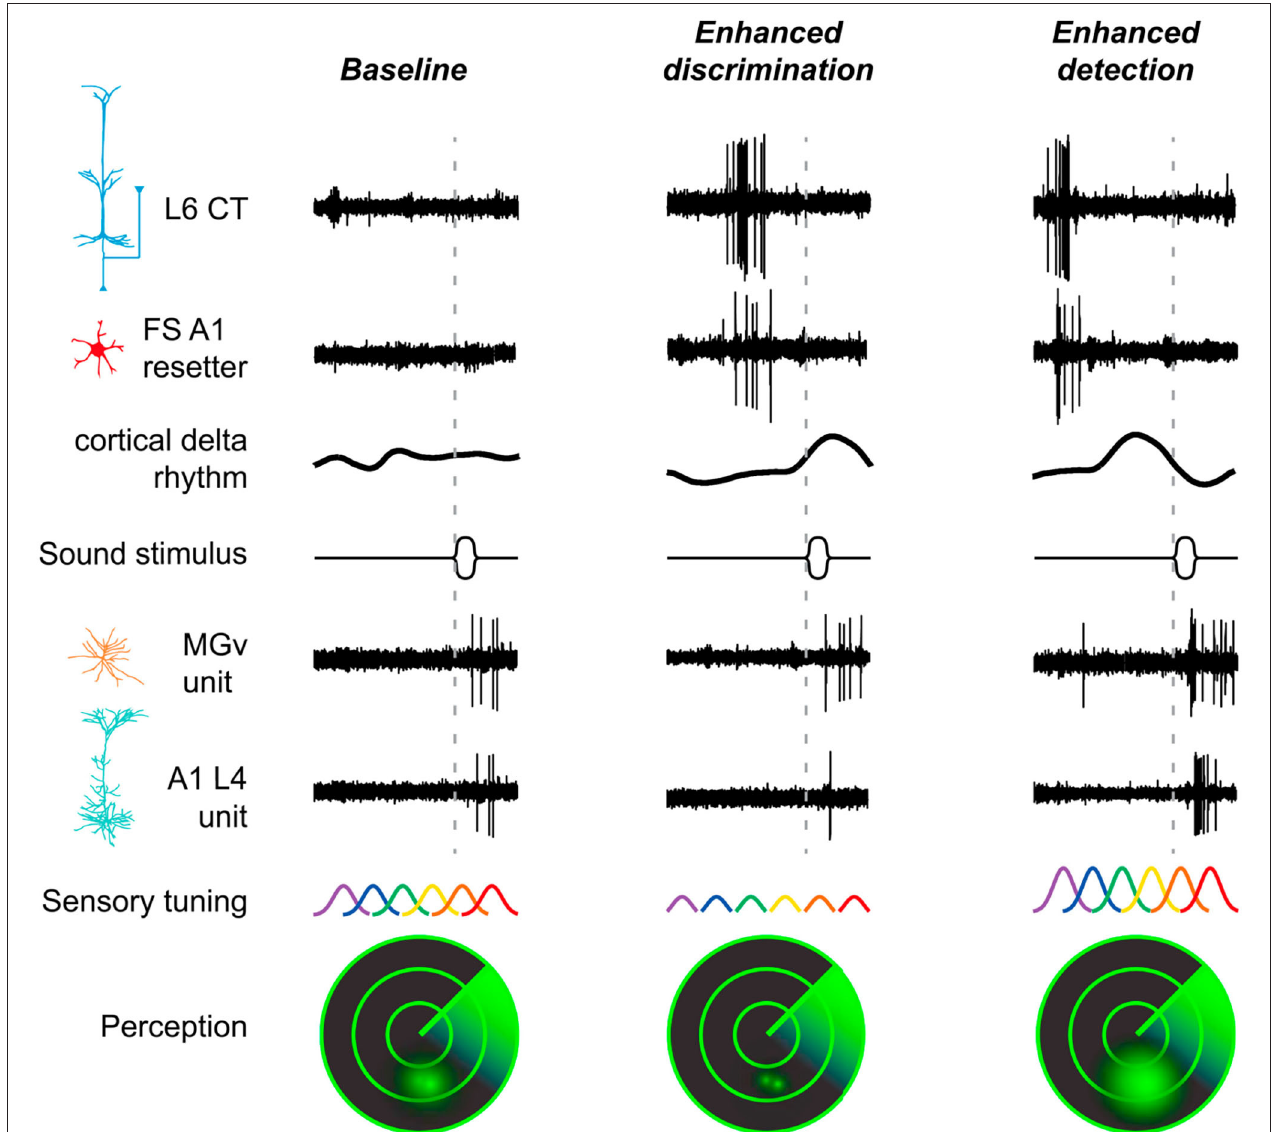
FIGURE 5 | L6 CT neurons are involved in the behavioral switch between sound detection and discrimination. This scheme summarizes the findings by Guo et al. (2017) who demonstrate the participation of L6 CT neurons (Ntsr1 + ), via both their intracortical and corticothalamic connections to perceptual modes of enhanced detection or discrimination. Left column, in a baseline condition with low activity in L6 CT neurons and fast-spiking interneurons (FS resetters), the sound-evoked activity in MGV and L4 cortical neurons is moderate. FS resetters are activated following intense firing of L6 CT neurons. Activity of FS resetters increases the power and resets the phase of low frequency rhythms. Middle column, at a short delay period following intense activity of L6 CT and FS resetter neurons, the delta-theta rhythm is at a positive, low excitability phase, and sound-evoked activity is suppressed in A1 but not in the MGV, which favors tone discrimination at the expense of sound sensitivity (the reduced excitability of cortical neurons sharpens frequency tuning). Right column, at longer delays following L6 CT activity, the phase of the cortical rhythm has rotated to a negative, high excitability phase, and sound-evoked activity is enhanced both in A1 and MGV. The enhanced excitability of cortical neurons is expected to increase the overlap in sensory tuning between neighboring tuning regions, which favors tone detection at the expense of reduced tone discrimination. A1, primary auditory cortex; CT, corticothalamic; L6, cortical layer 6; L4, cortical layer 4; MGV, ventral subdivision of the medial geniculate body; FS, fast-spiking interneurons. Reproduced, with permission, from Guo et al.